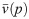
Conduction velocity along progressively remyelinated axons.The black squares represent the average CV (and standard deviation) for 500 model neurons with a given fraction of remyelinated segments. The blue solid curve is the benchmark velocity v¯(p). The red circles represent the CV for an axon with uniform internode length given by the average internode length of the remyelinated model neurons.